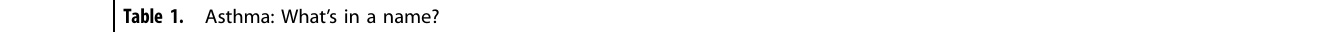
young children ’ . v